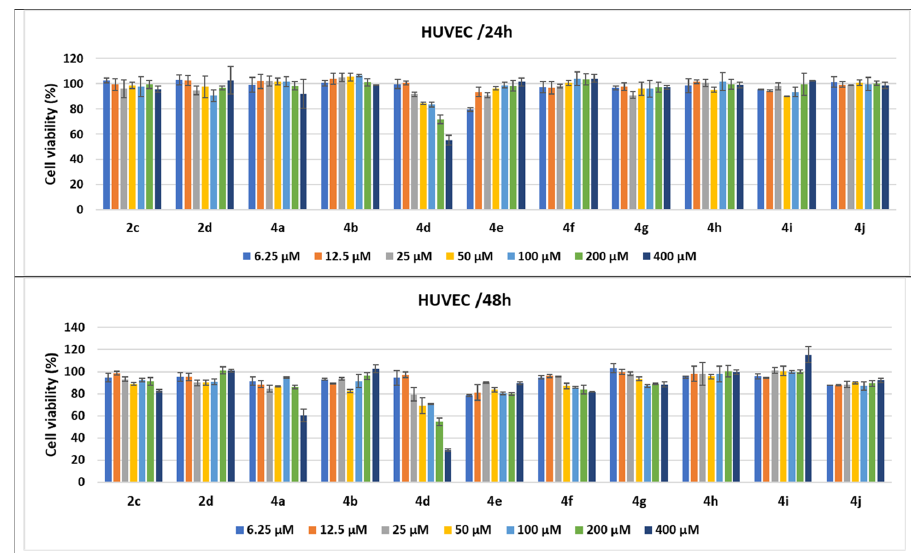
Figure 13. Antitumor effect of tested compounds against HUVECs. The cell viability was measured after HUVEC treatments with scalar concentrations of the tested compounds for 24 or 48 h and compared to that of untreated control cancer cells. Data are expressed as the mean values ± standard deviations (SDs) of three different experiments ( n = 3 ).